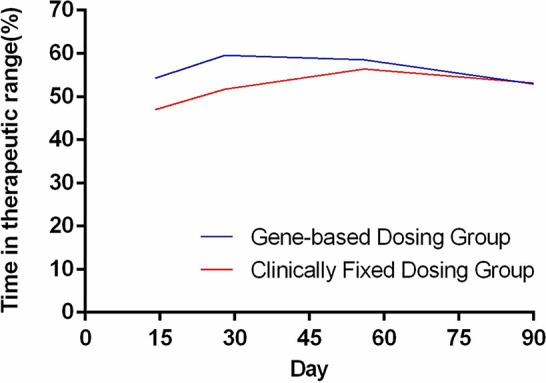
Time needed to reach the therapeutic INR.